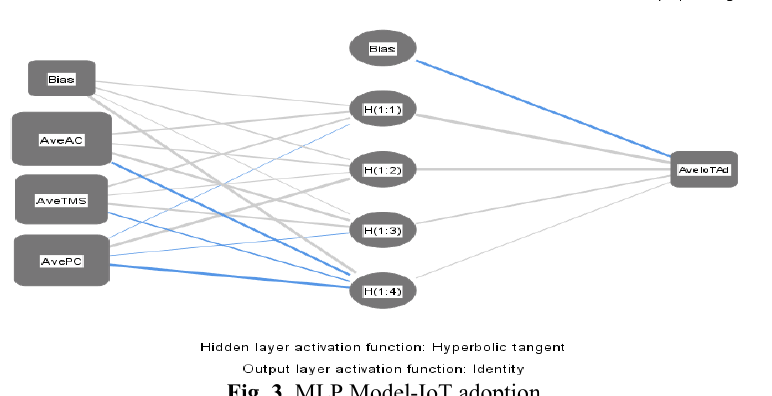
Fig. 3. MLP Model-IoT